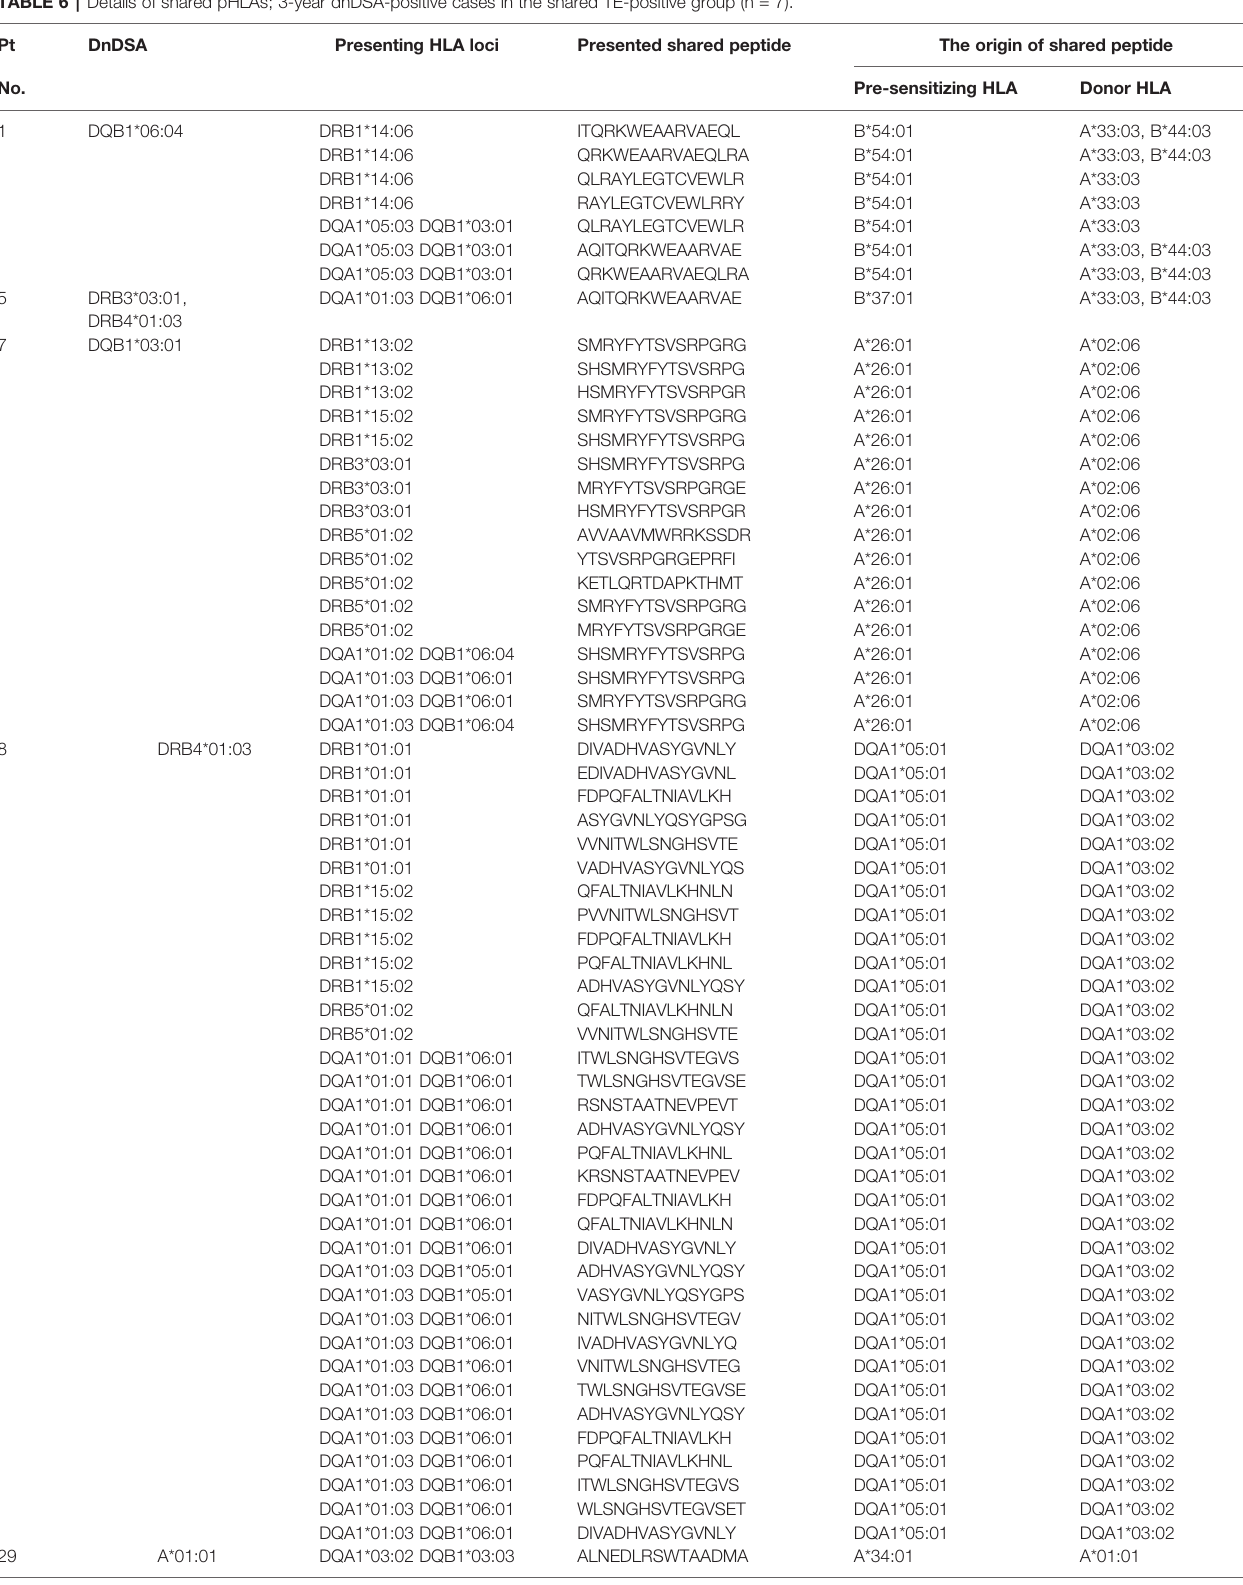
TABLE 6 | Details of shared pHLAs; 3-year dnDSA-positive cases in the shared TE-positive group (n =